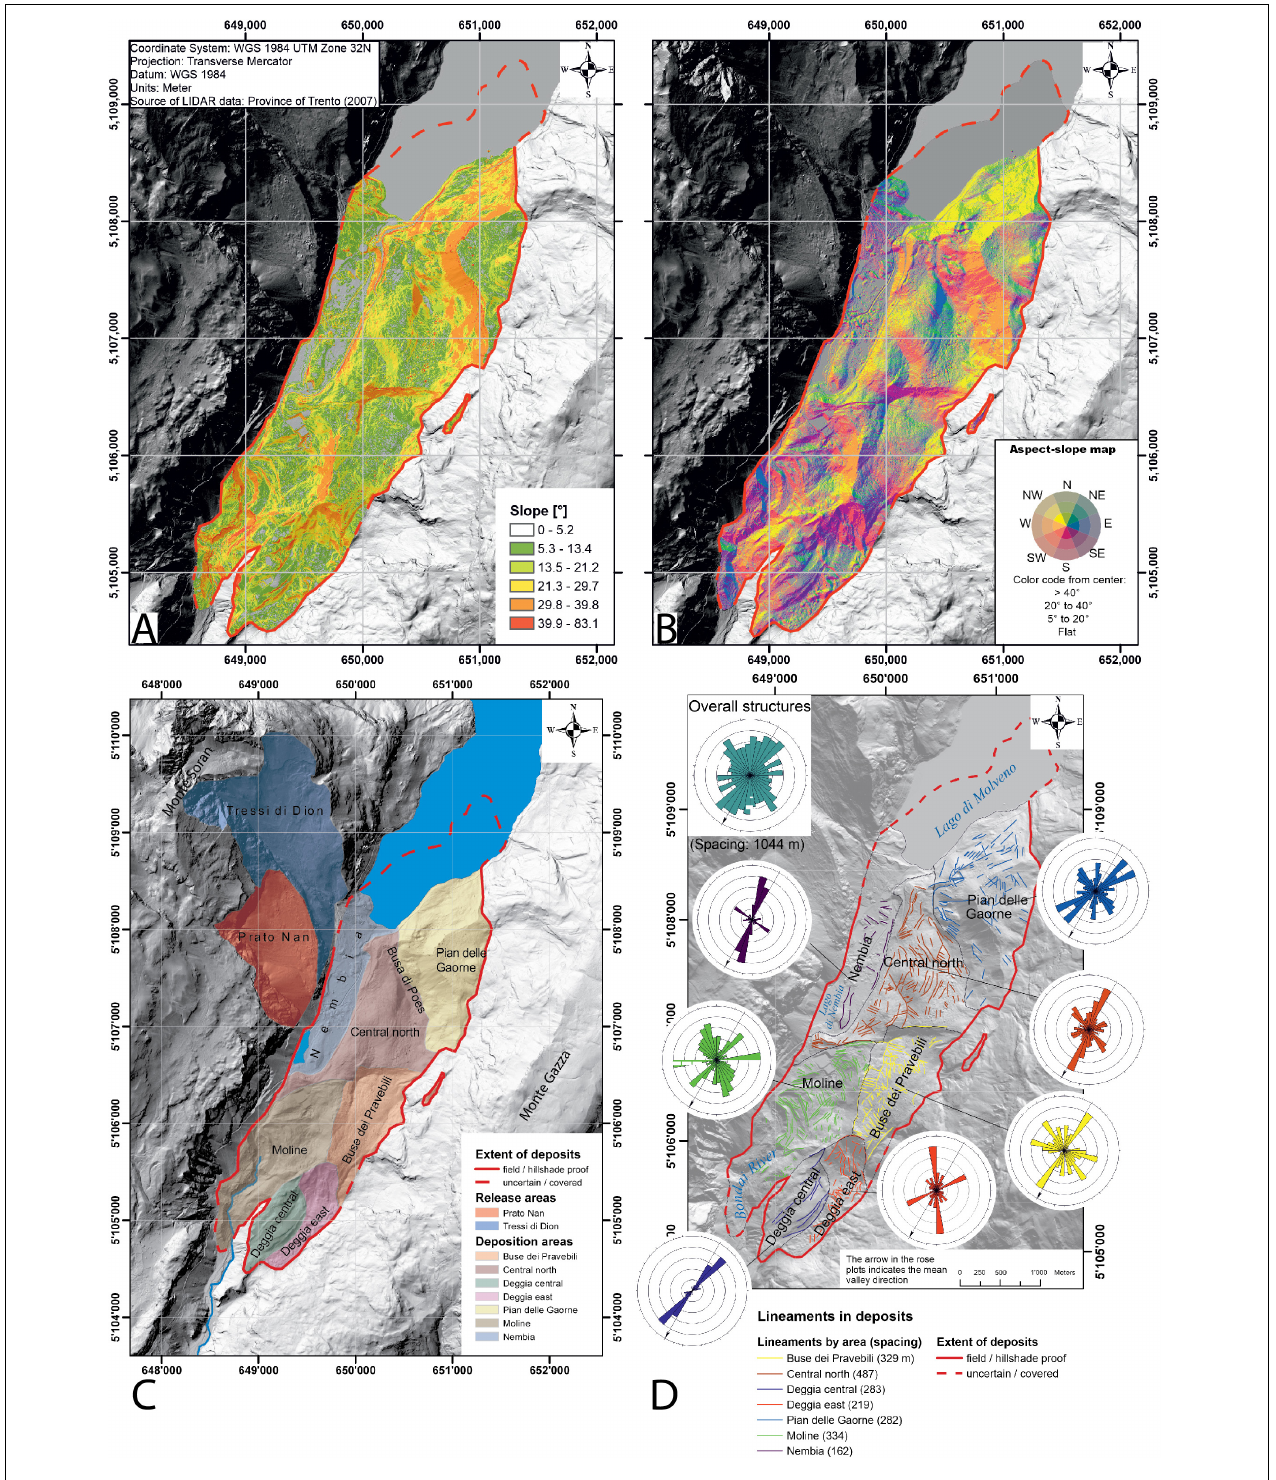
FIGURE 2 | (A) Slope map of the Molveno deposits. (B) Aspect map of the deposits. (C) Landslide regions. Deposition and release area. The red line encircles the mapped landslide deposits. The proposed release area is in the Northwest, it comprises Prato Nan and Tressi di Dion. (D) Lineament map of deposit structures. For each of the landslide areas lineaments were drawn on the aspect-slope map and hillshade. The lineaments are plotted length normalized as rose plots, i.e., the direction with greatest cumulative length is the longest rosette branch, and so on. A bin size of 10 ◦ was chosen. The concentric circles on each plot correspond to lineament length, with spacing the circles indicated on the legend. Map coordinate system: WGS 1984 UTM Zone 32N.